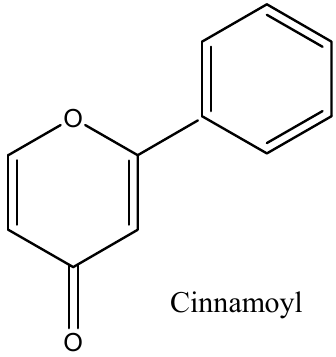
Figure 2. Structural base of the cinnamoyl system.